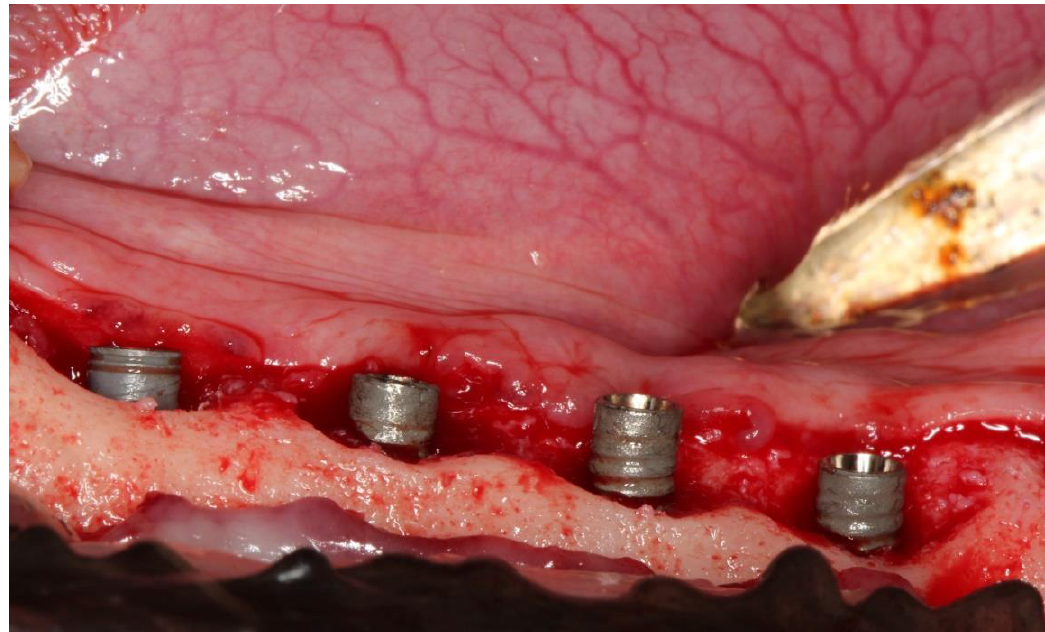
Figure 3. Massive horizontal bone loss results in merging bone defects and massive resorption of the whole ridge.